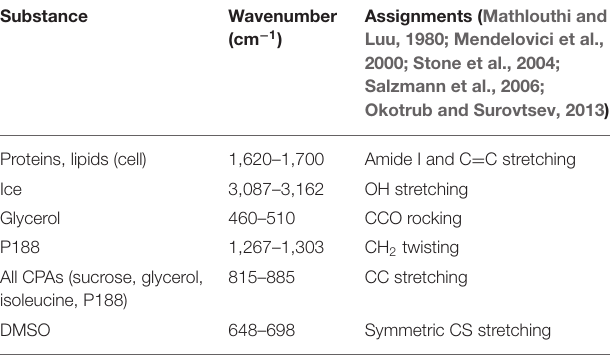
TABLE 2 | Raman spectral peak assignments a